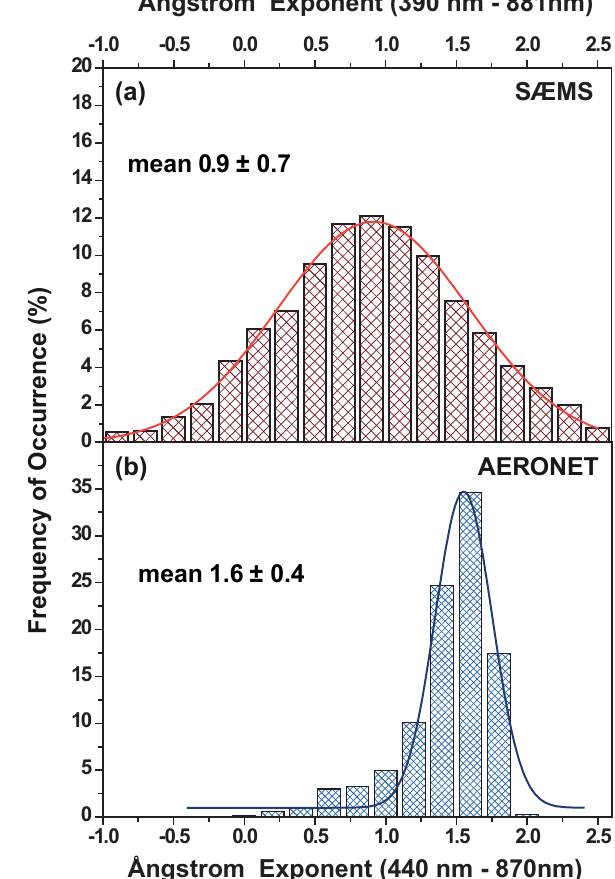
Fig. 12. Frequency distribution of Ångström exponents as observed with (a) SÆMS at 30–50m height above ground in 2009 and (b) with an AERONET photometer in the vertical column in